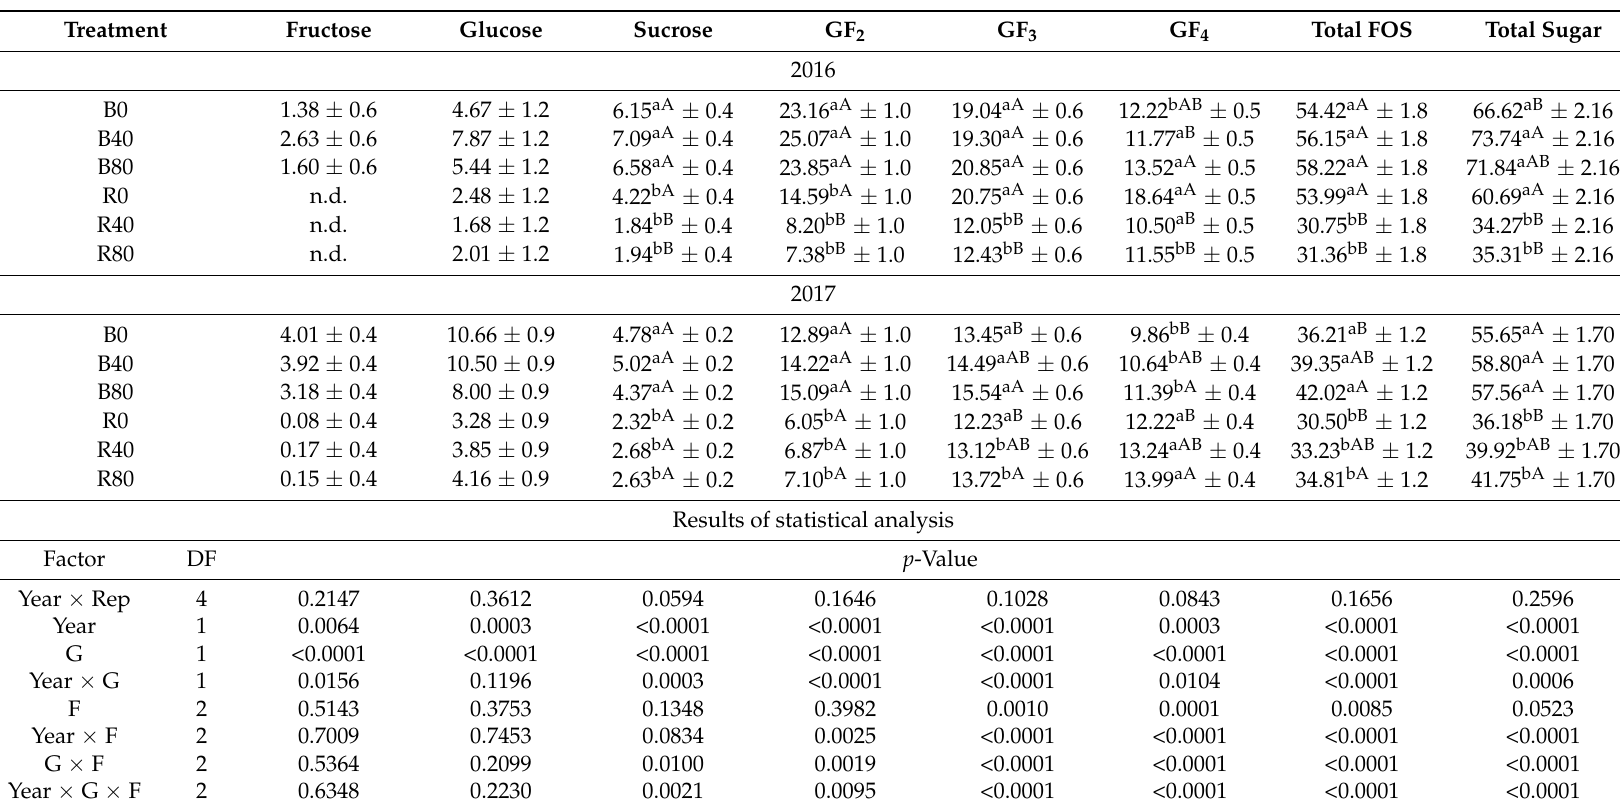
Table 4. Fructose, glucose, sucrose, GF 2 , GF 3 , GF 4 , total fructooligosaccharides (FOS), and total sugar content in % of dry matter (DM) for the two years (2016 and 2017) of the six treatments (B0, B40, B80, R0, R40, and R80) at harvest, notated as the mean value ± standard